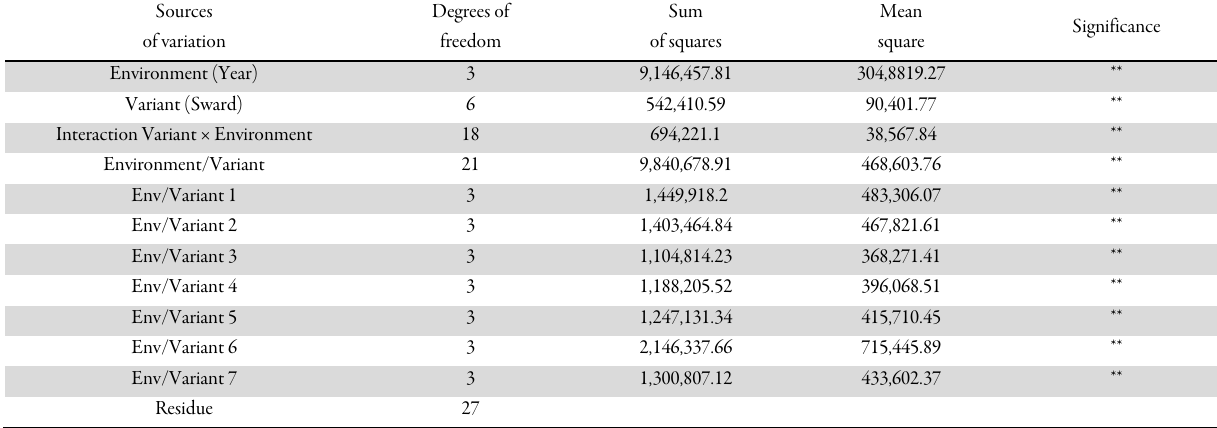
Fig. 2. Influence of factors Table 1. Analysis of variance in regard to productivity of the studied swards Sources